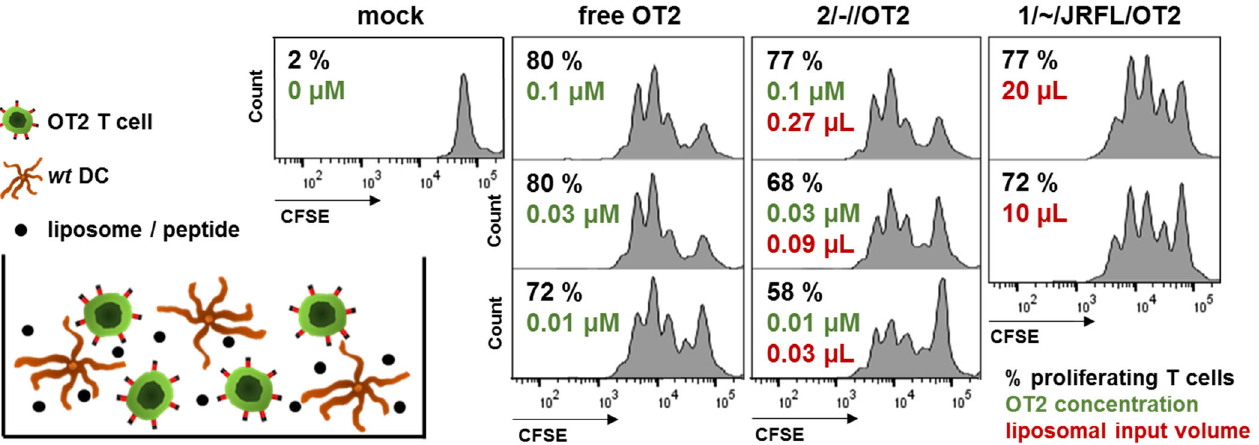
Figure 2. Functional comparison of peptide encapsulation in 2/-//OT2 and 1/~/JRFL/OT2. Co-cultures of 2 × 10 5 wild-type dendritic cells ( wt DCs) and 5 × 10 4 CFSE-labeled OT2-specific T cells (OT2 T cell) were incubated in the presence of liposomal formulations (2/-//OT2 and 1/~/JRFL/OT2) or free OT2 peptide for 72 h. OT2 T cell proliferation was evaluated by flow cytometry based on the CFSE distribution in offspring cells. Proliferation in % (black), bulk OT2 concentration (green) and input volume of liposomal stock solution (red) are given for each culture well. The experiment was performed three times with comparable results.